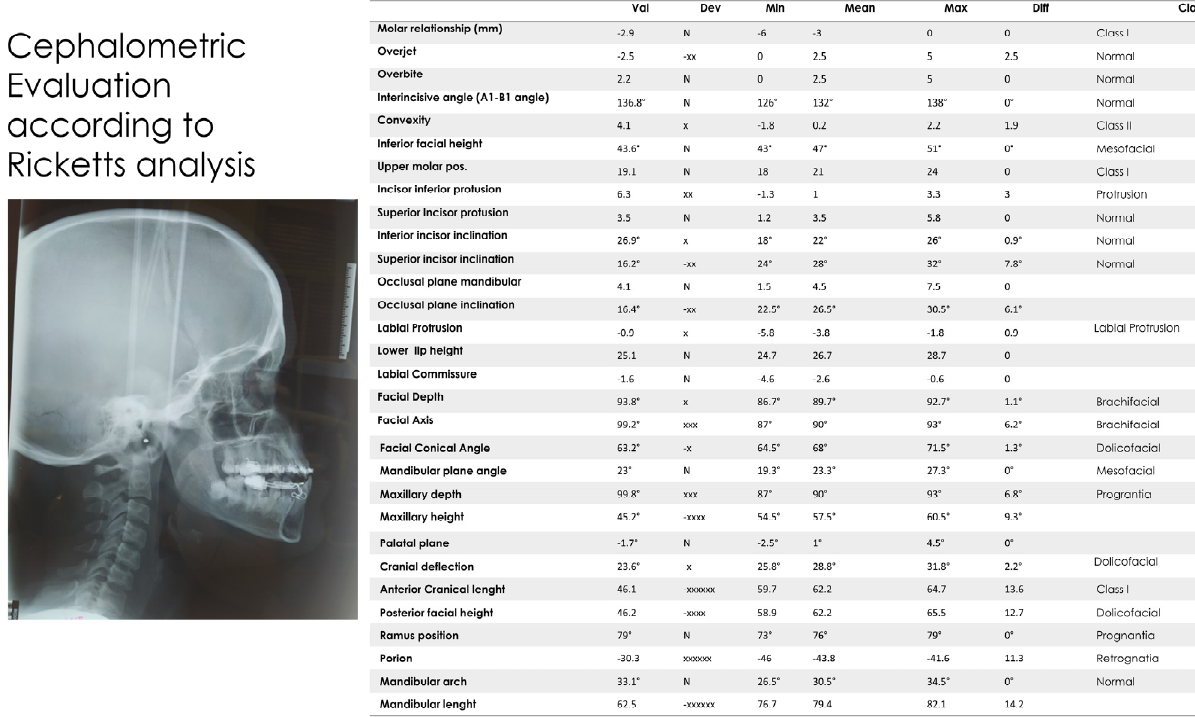
Figure 16. Ricketts cephalometric analysis in 2021 (Deltadent ® , Outside Format—Pavia